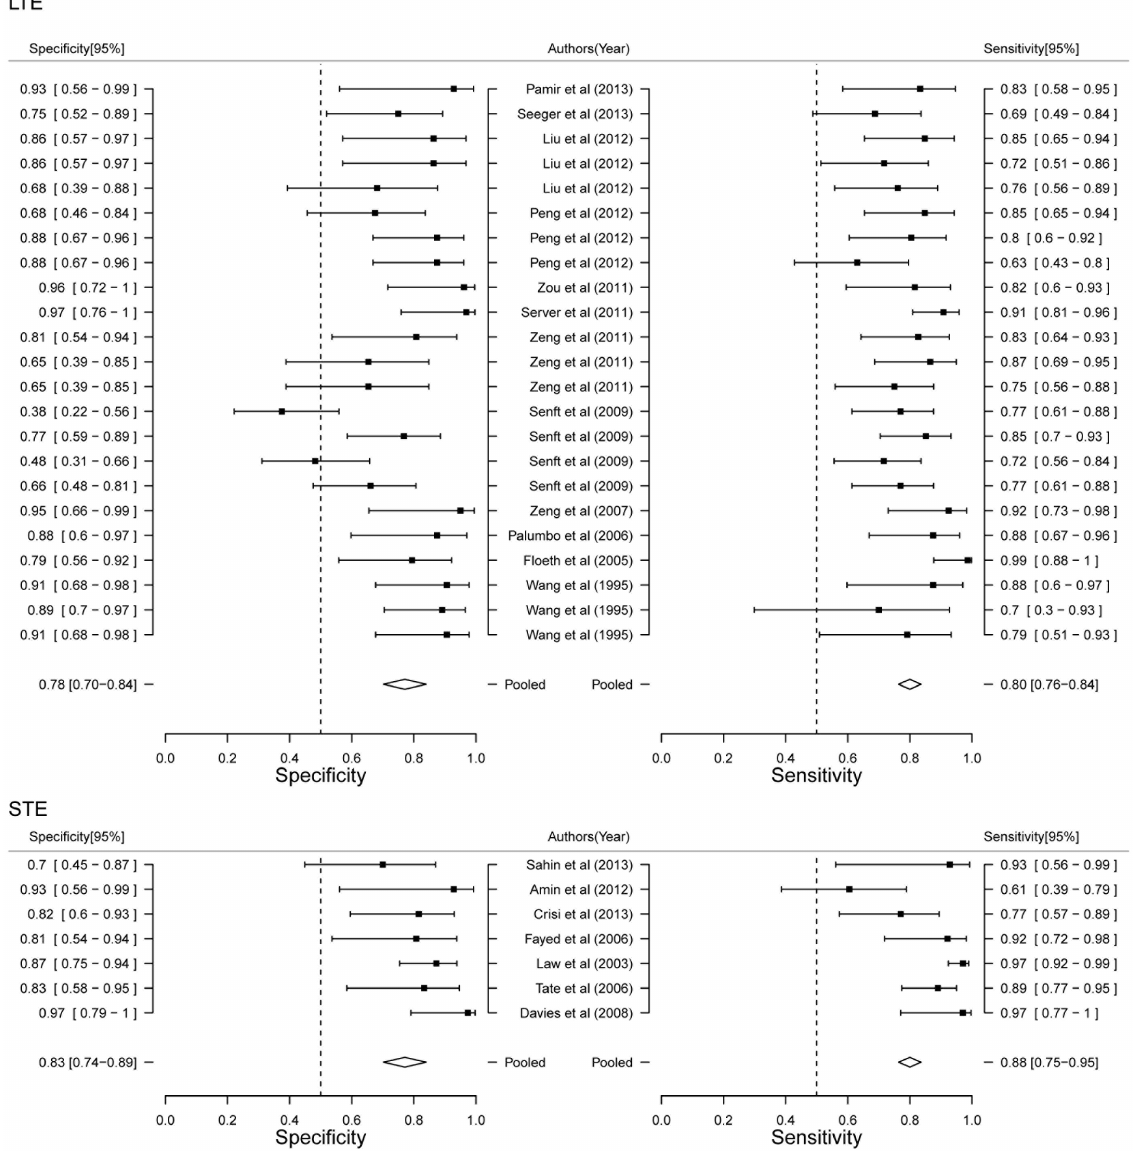
Figure 7. Forest plot of estimate of diagnostic accuracy of LTE and STE stratified meta-analysis.